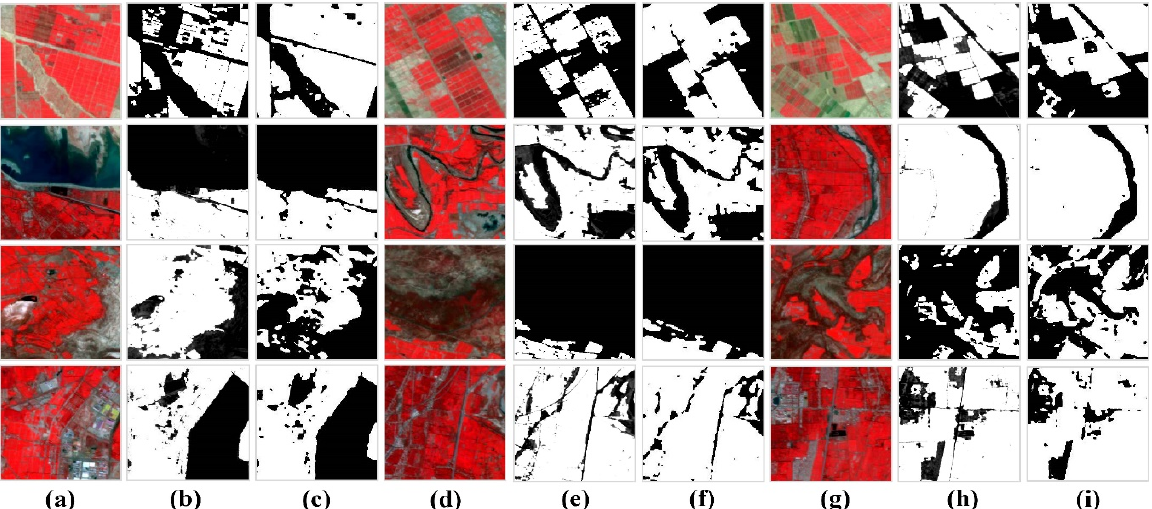
Figure 7. The cotton identification results from 12 subimages by the DenseNet model. The figure is divided into four rows and nine columns. Columns ( a , d , g ) are the false color subimages; column ( b , e , h ) are the corresponding ground truths; column ( c , f , i ) are the DenseNet predictions.